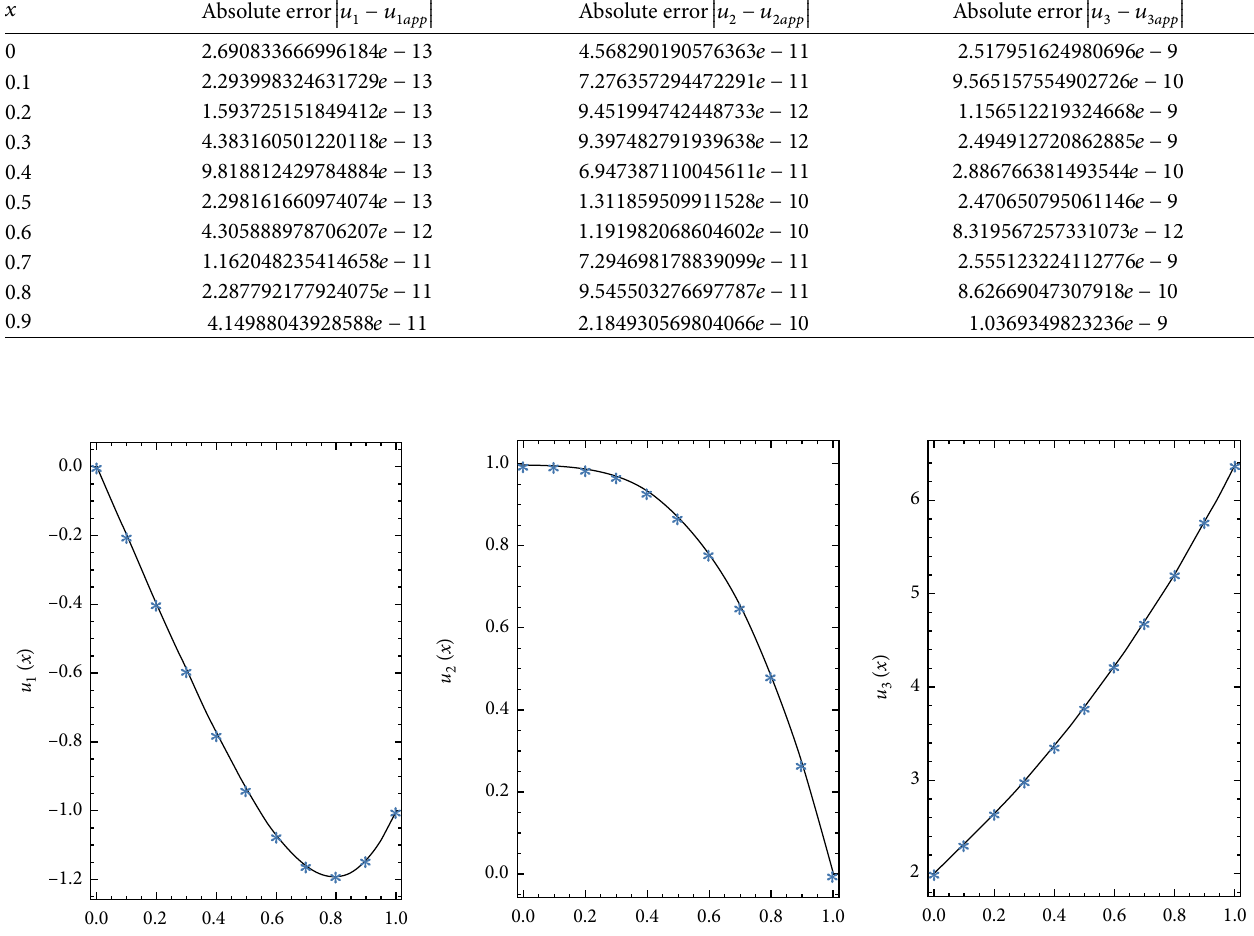
. (a) The exact and 푀 = 8 𝑢 3